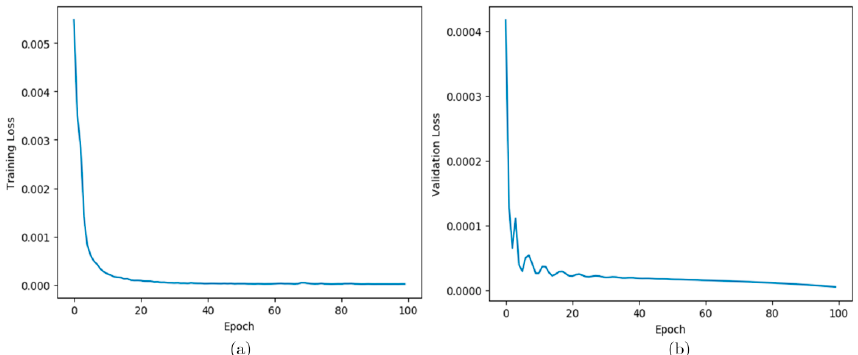
Figure 13. GPR simulation data under the layered background medium for training regression networks. ( a ) The MSE loss of training data; ( b ) the MSE loss of validation data. The above trained regression network is used to predict the permittivity ε T of the targets; the prediction results on 200 test images are shown in Figure